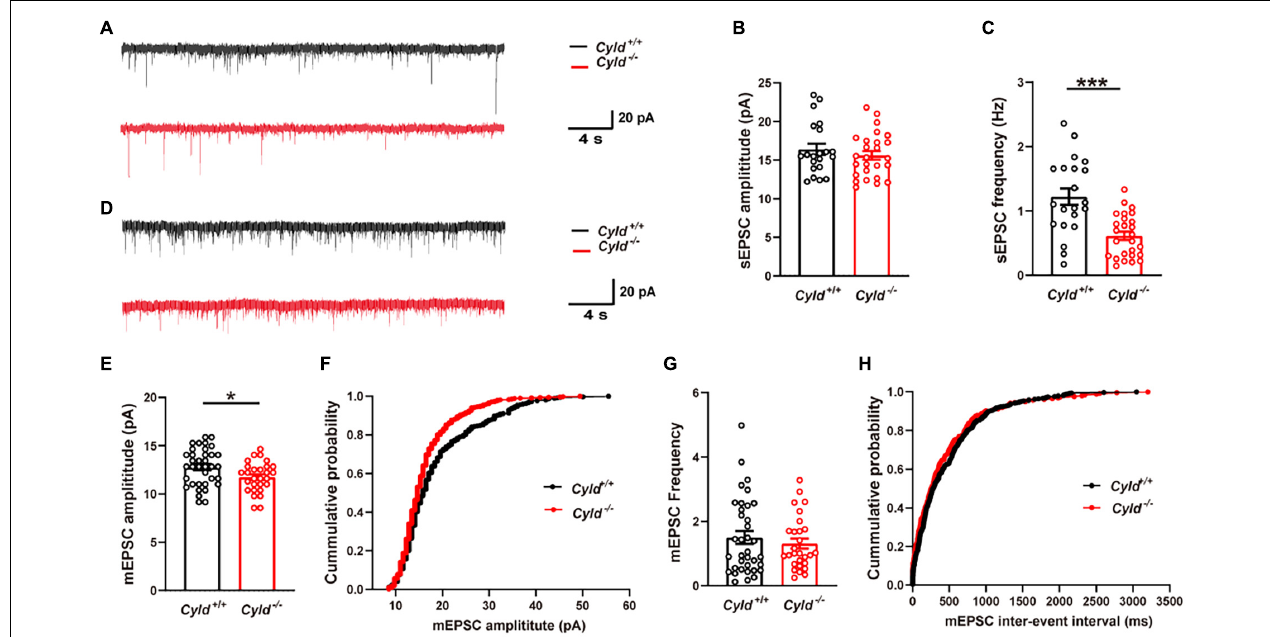
FIGURE 4 | Compromised excitatory synaptic transmission in the BLA of Cyld − / − mice. (A) Representative sEPSC traces continuously recorded from BLA principal neurons. (B) The sEPSC amplitude of principal neurons in the BLA was comparable between Cyld + / + and Cyld − / − mice. n = 26 neurons from seven mice for the Cyld knockout group, and n = 21 neurons from seven mice for the Cyld + / + group. (C) Principal neurons in the BLA of Cyld − / − mice showed a significant decrease in sEPSC frequency. n = 26 neurons from seven mice for the Cyld knockout group, and n = 21 neurons from seven mice for the Cyld + / + group. (D) Representative mEPSC traces continuously recorded from BLA principal neurons. Average amplitude (E) and cumulative probability of amplitude (F) of mEPSCs in BLA principal neurons. n = 36 neurons from six mice for the Cyld + / + group, and n = 28 neurons from four mice for the Cyld knockout group. Average frequency (G) and cumulative probability of the interevent intervals (H) of mEPSCs in BLA principal neurons. n = 36 neurons from six mice for the Cyld + / + group, and n = 28 neurons from four mice for the Cyld knockout group; Student’s t -test, *p < 0.05, *** p < 0.001. Data are presented as mean ± SEM.